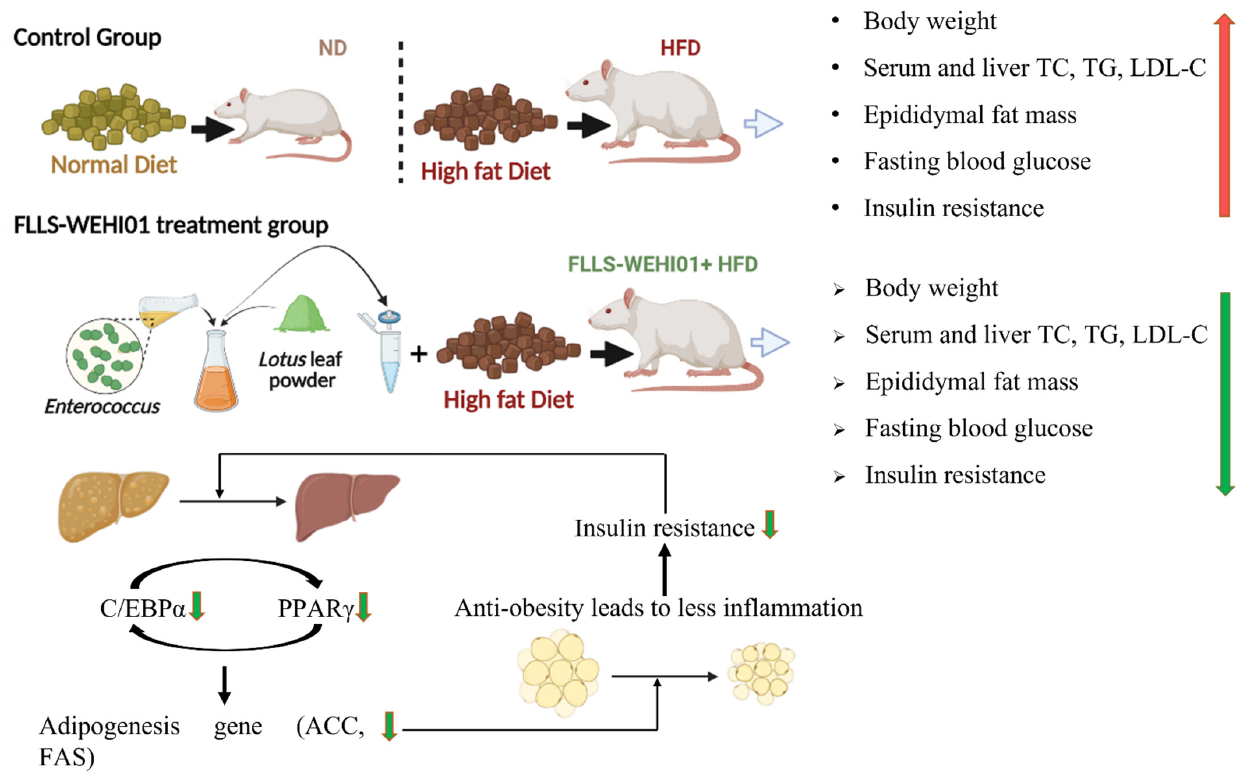
Figure 9. The schematic diagram of the anti-obesity ability of WEHI01-fermented lotus leaf super- natant. ND, normal diet; HFD, high-fat diet; FLLS-WEHI01, Enterococcus hirae WEHI01-fermented lotus leaf supernatant; TC, total cholesterol; TG, total triglyceride; LDL-C, low-density lipoprotein cholesterol; C/EBP α , CCAAT/enhancer-binding protein α ; PPAR γ , peroxisome proliferator activated receptors γ ; ACC, acetyl-CoA carboxylase; FAS, fatty acid synthase.